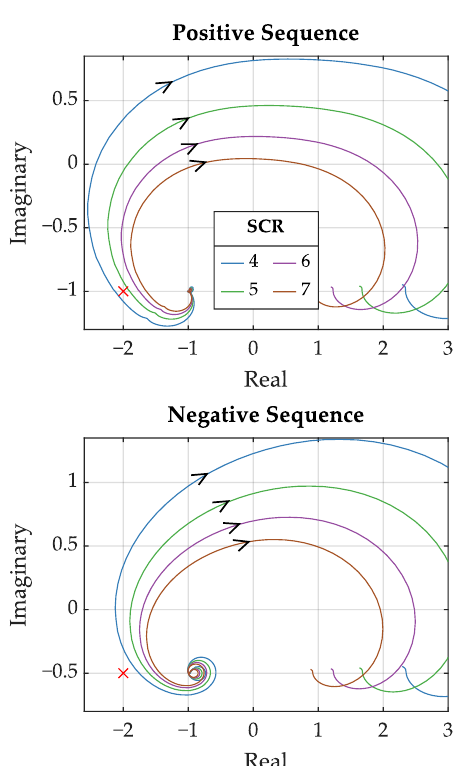
Figure A1. Nyquist plots of AC grid and MMC impedance ratio of validation test case.